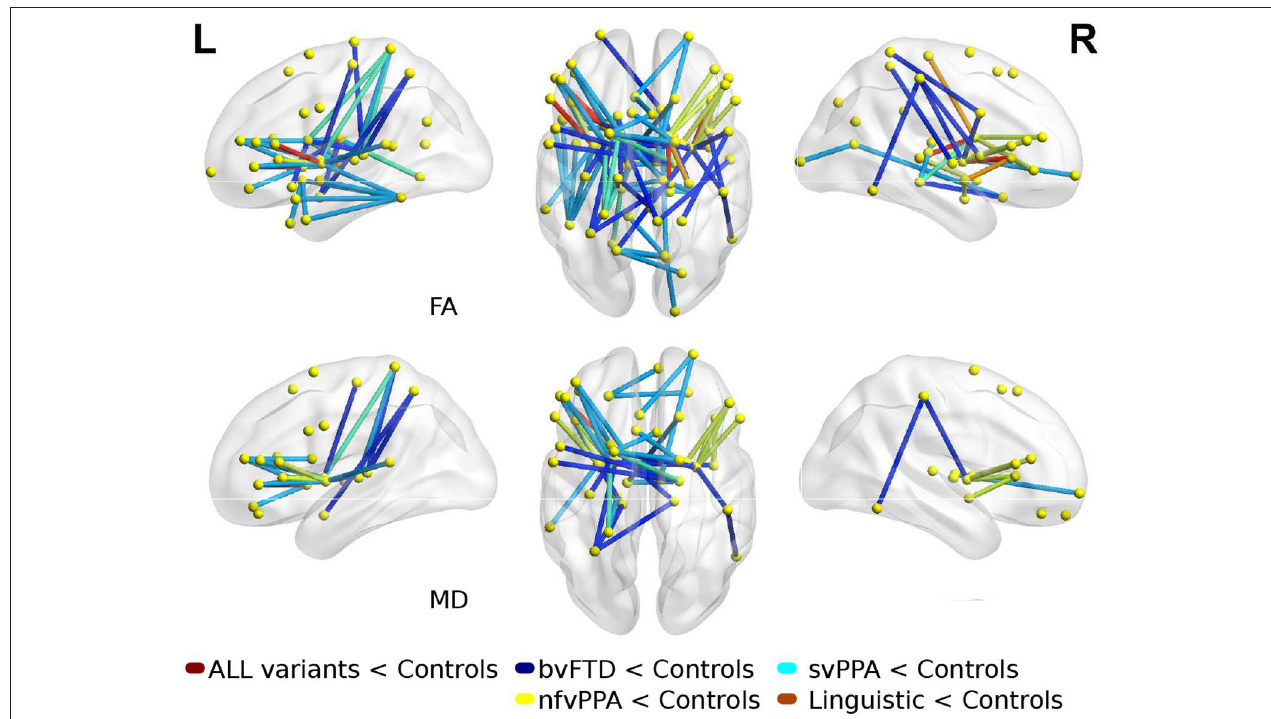
FIGURE 2 | Atrophic networks in linguistic variants and bvFTD with respect to controls. Top figures show changes in fractional anisotropy (FA) and bottom show changes in mean diffusivity (MD). The figure shows alterations overlaid on a 3D template in the Montreal Neurological Institute’s standard space in neurological